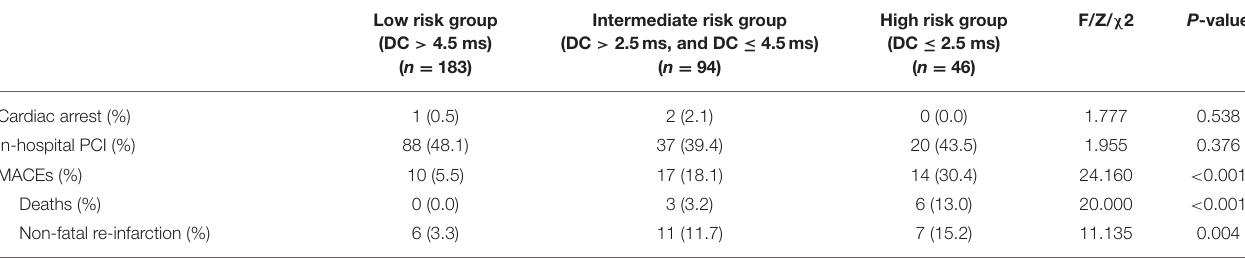
Cox analysis indicated that NLR (HR: 1.041, 95% CI: 1.000–